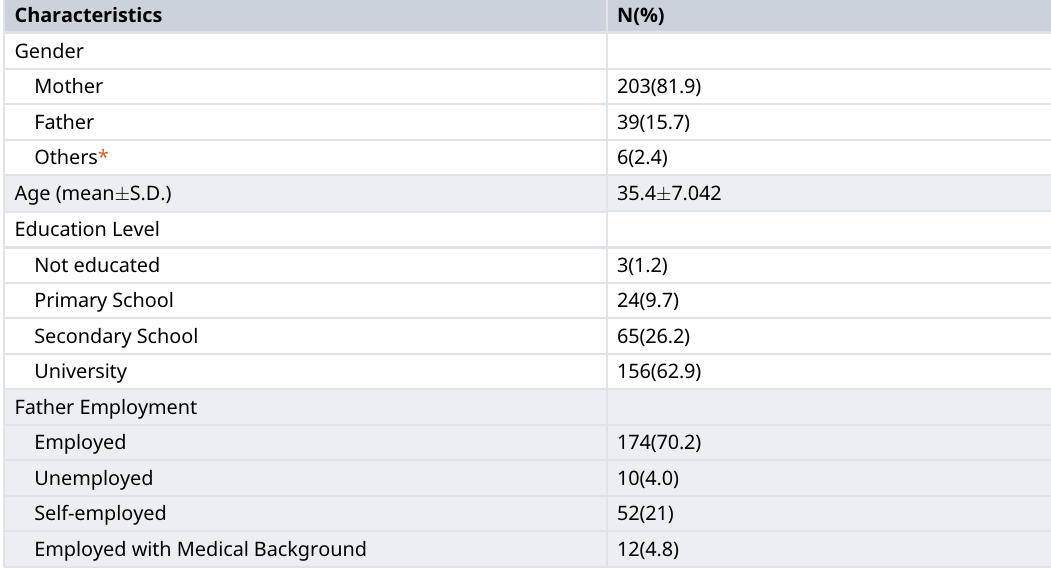
Table 1. Sociodemographic parameters of the study participants.